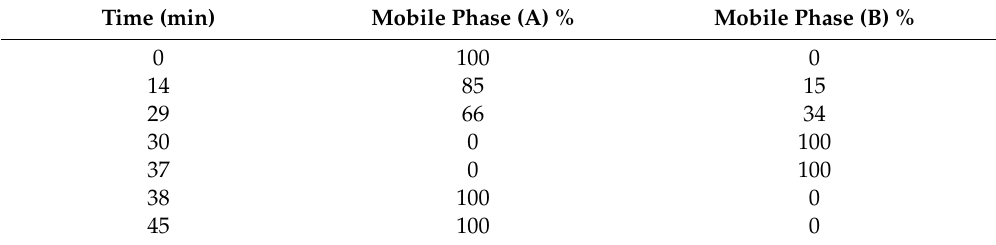
Table 2. Elution